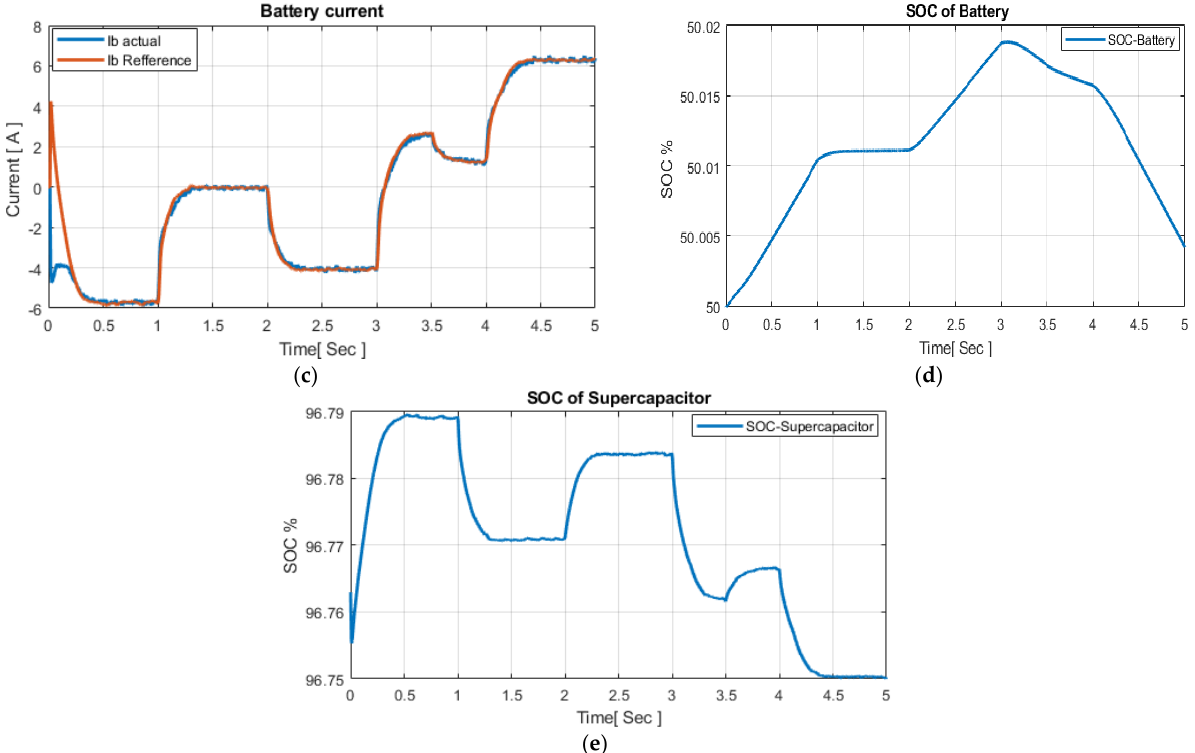
Figure 5. Results with the conventional PI method: ( a ) DC-link voltage; ( b ) power exchange; ( c ) battery current; ( d ) SOC of battery; ( e ) SOC of supercapacitor.